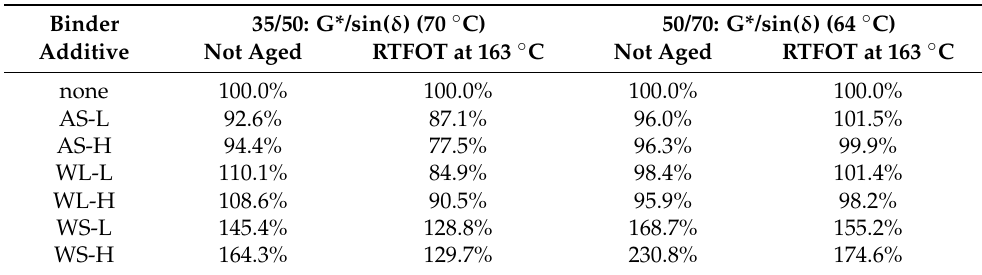
Table 7. Effects of the investigated additives on the high-temperature stiffness (G*/sin( δ )) of the 35/50 and 50/70 binders before and after short-term laboratory